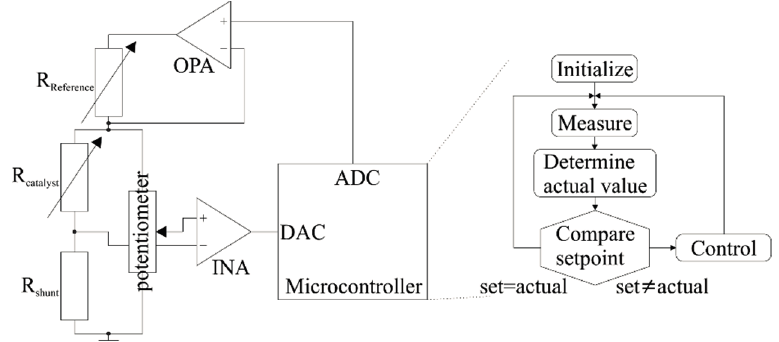
Figure 3. Schematic of the electronic circuit for digital controlling of the heater temperature by a